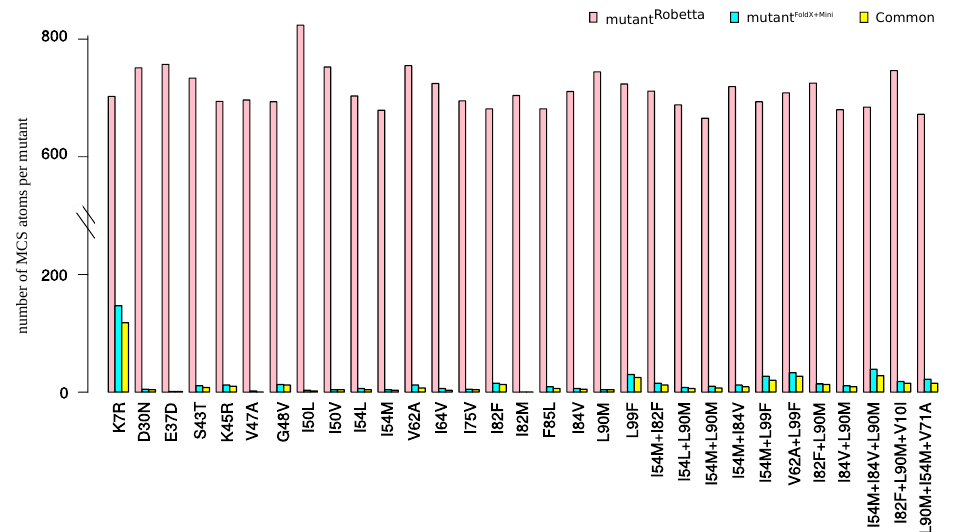
Figure 9. Number of MCS atoms in the mutant Robetta set, in the mutant FoldX + mini set, and observed both in the two mutant